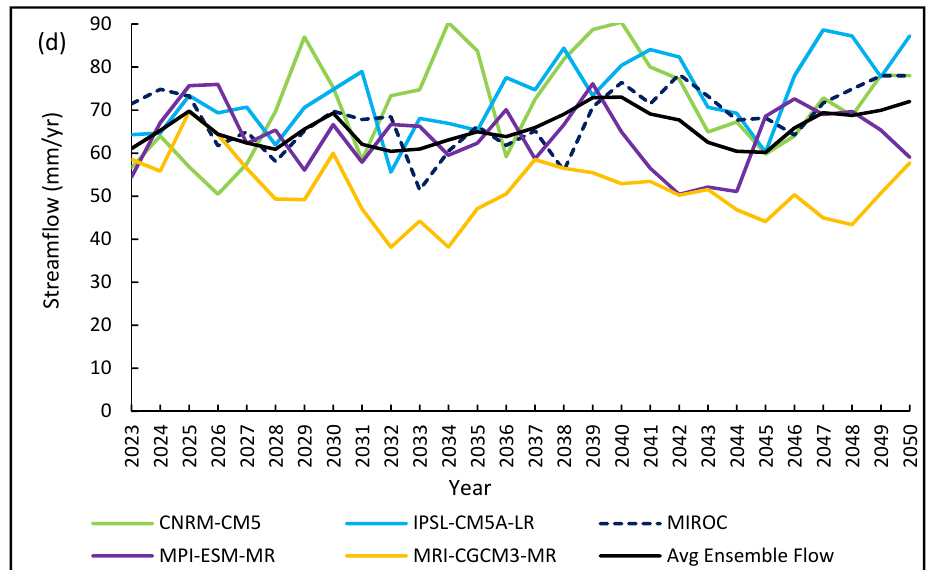
Figure 3. ( a ) Baseline ensemble streamflow with the average; ( b ) RCP 4.5 ensemble streamflow with the average; ( c ) RCP 8.5 ensemble streamflow based on high uncertainty with the average; and ( d ) RCP 8.5 ensemble streamflow based on strong consensus with the average.